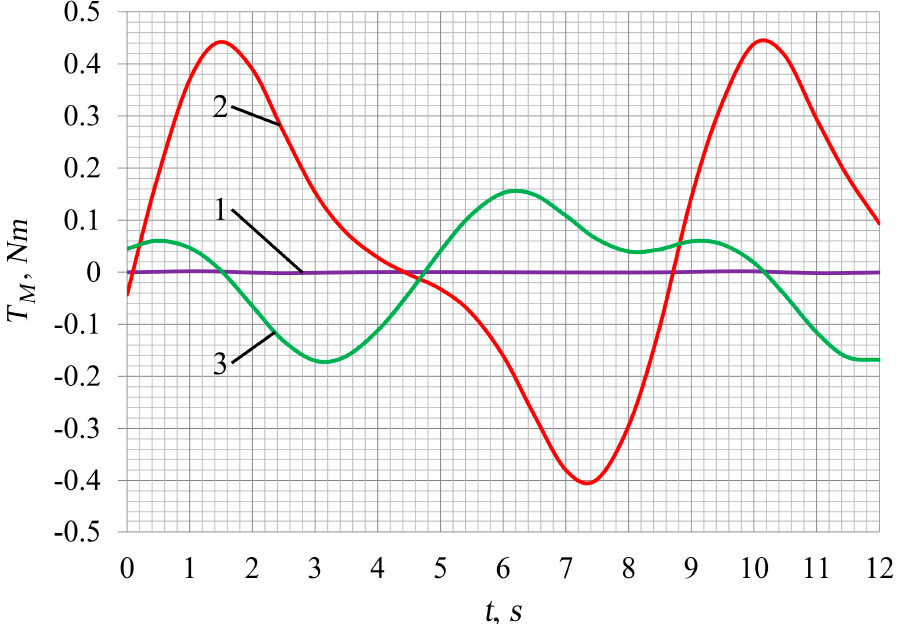
Figure 5. Time-dependent diagrams of the hexapod motor torque ( T M ) for the different cranks Time-dependent diagrams of the hexapod motor torque ( T M ) for the different initial positions: 1—{ β i = 255.8°}, the output link only rotates around the vertical axis; 2—{ β 1 = β 3 = β 5 cranks initial positions: 1—{ β i = 255.8 ◦ }, the output link only rotates around the vertical axis; 2—{ β 1 = β 3 = β 5 = 104.2 ◦ and β 2 = β 4 = β 6 = 255.8 ◦ }, the output link has simultaneous rota- = 104.2° and β 2 = β 4 = β 6 = 255.8°}, the output link has simultaneous rotation and displacement rela- tion and displacement relative to the vertical axis; 3—{ β 1 = 287.6 ◦ , β 2 = 103.3 ◦ , β 3 = 278.4 ◦ , tive to the vertical axis; 3—{ β 1 = 287.6°, β 2 = 103.3°, β 3 = 278.4°, β 4 = 263.8°, β 5 = 260.6°, β 6 = 242.4°}, the ◦ , β ◦ , β ◦ }, the output link performs general spatial motion changing β output link performs general spatial motion changing all six coordinates. 4 = 263.8 5 = 260.6 6 = 242.4 all six